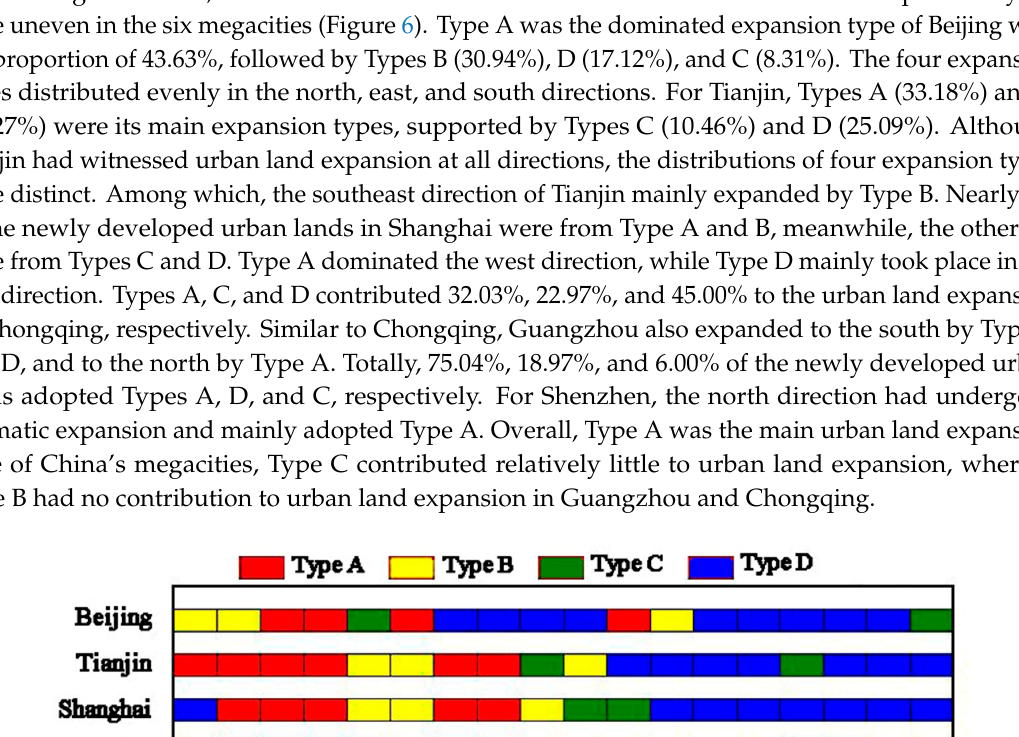
Figure 6. Urban land expansion types of China’s megacities: ( a ) Distributions and ( b ) proportions.